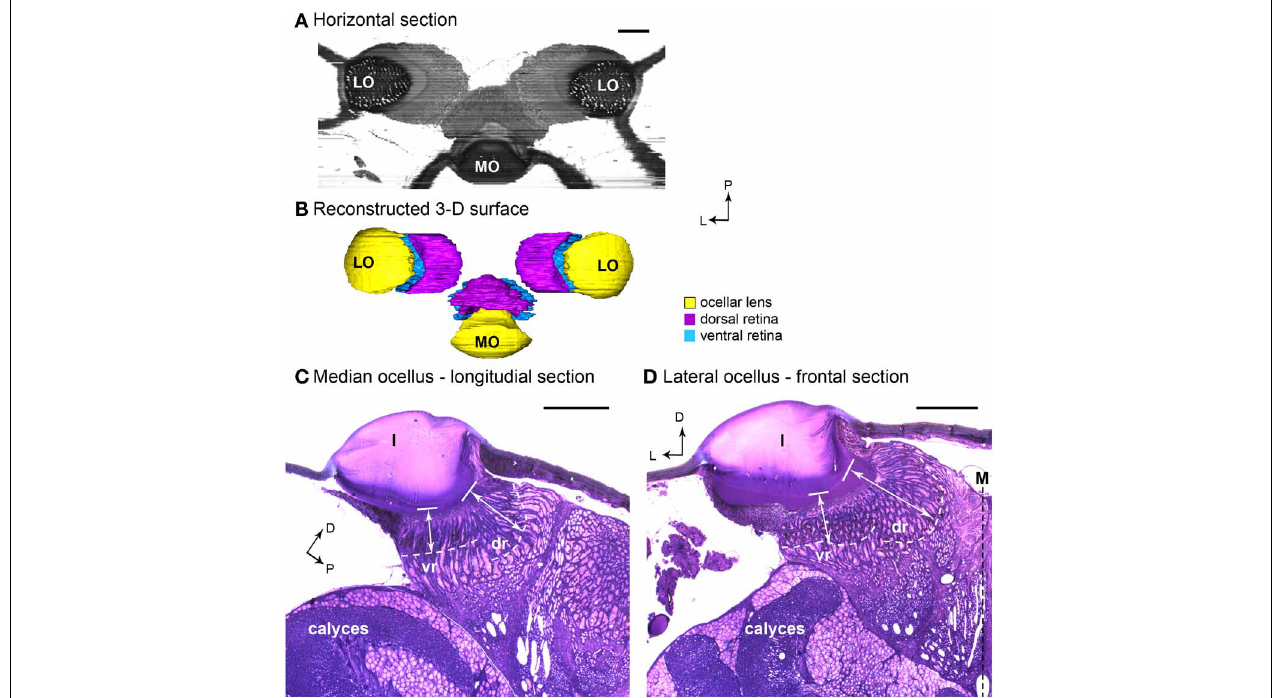
FIGURE 1 | Light micrographs of honeybee ocellar semi-thin sections. (A) Horizontal plane of the three ocelli reconstructed from serial sections. The lens and retina of the median ocellus project dorsally while the lateral ocelli project slightly ventrally and toward the midline of the brain. (B) 3-D reconstructed model of the dorsal ocelli of the honeybee. (C) Longitudinal section of the median ocellus. The lens is a thick, dome shaped, spherical biconvex corneal lens. (D) Cross section of the lateral ocellus. The outer surface of the ocellar lens is smooth and convex, but the inner surface curves asymmetrically toward the midline of the brain ( M). The white